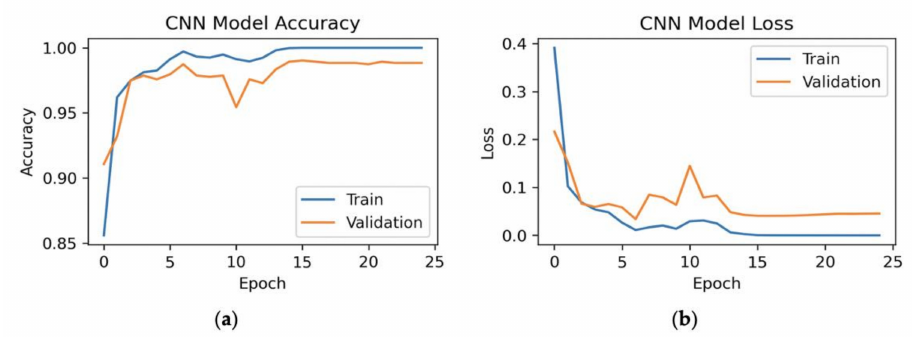
Figure 14. Experimental results for all the features: ( a ) epoch vs. accuracy and ( b ) epoch vs. loss.